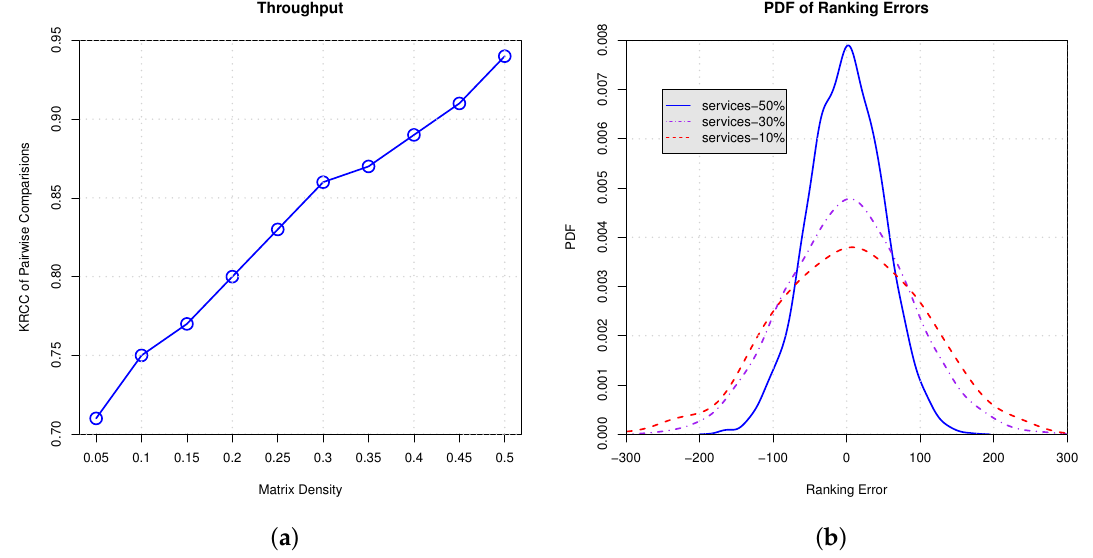
Figure 11. Ranking on throughput with different proportion of services selection. ( a ) KRCC of pairwise comparisons; ( b ) PDF of ranking